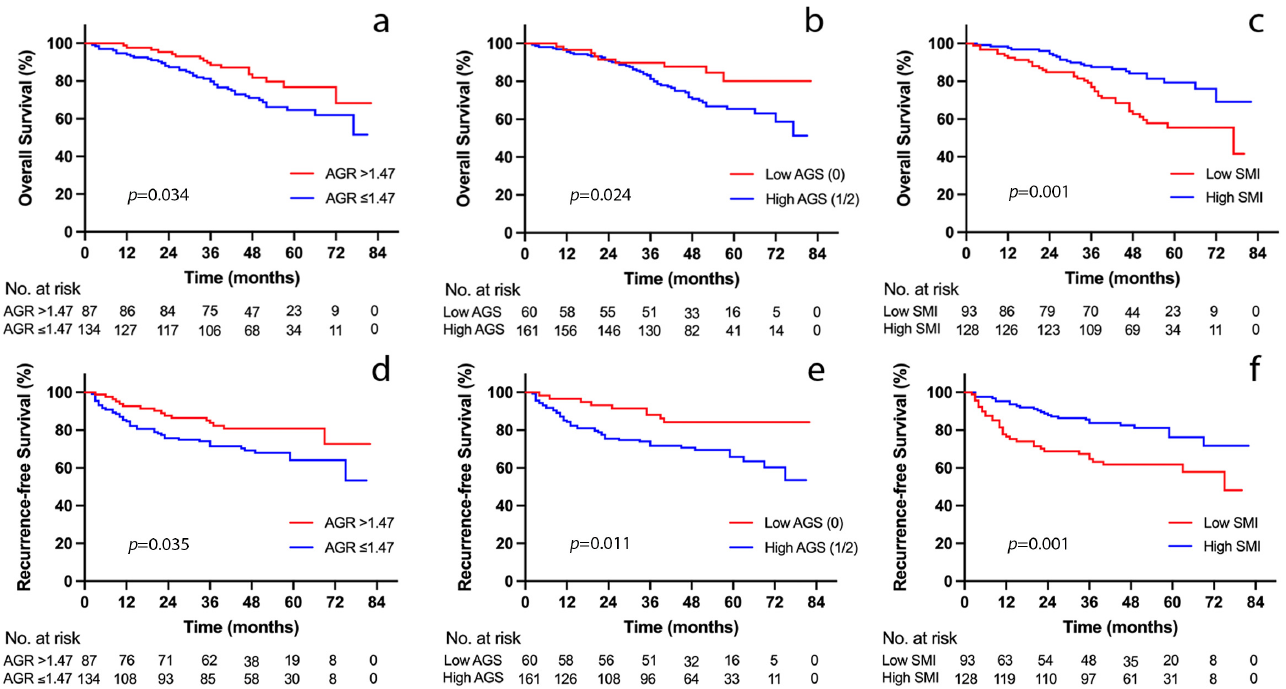
Figure 3. Kaplan–Meier curves for overall survival and recurrence-free survival stratified by AGR ( a , d ), AGS ( b , e ), and SMI ( c , f ) in the study cohort. AGR, albumin-to-globulin ratio; AGS, albumin–globulin score; SMI, skeletal muscle index.